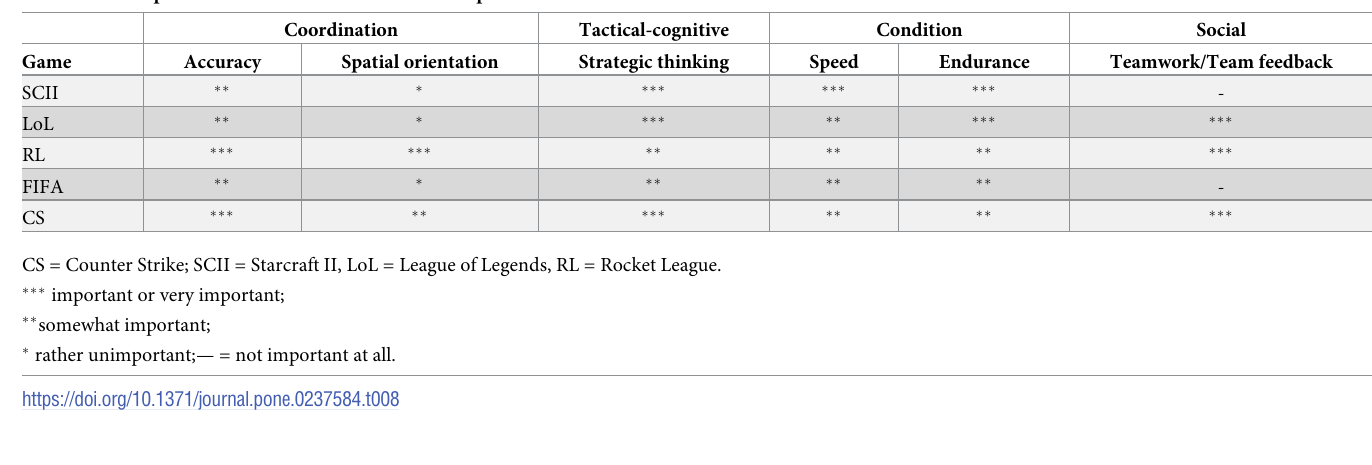
Table 8. Assumptions about differences between the